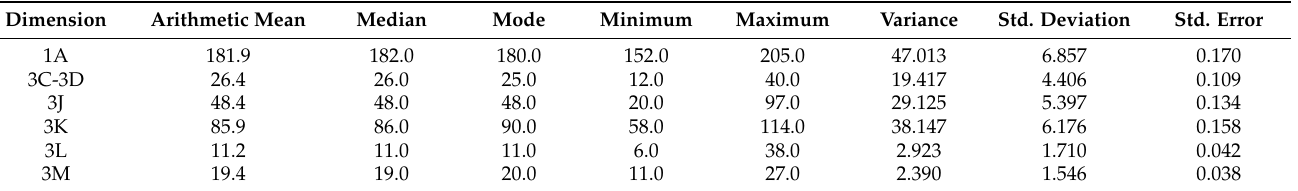
Table 2. Descriptive statistics for anthropometric dimensions according to EN ISO 3411 on analyzed population during